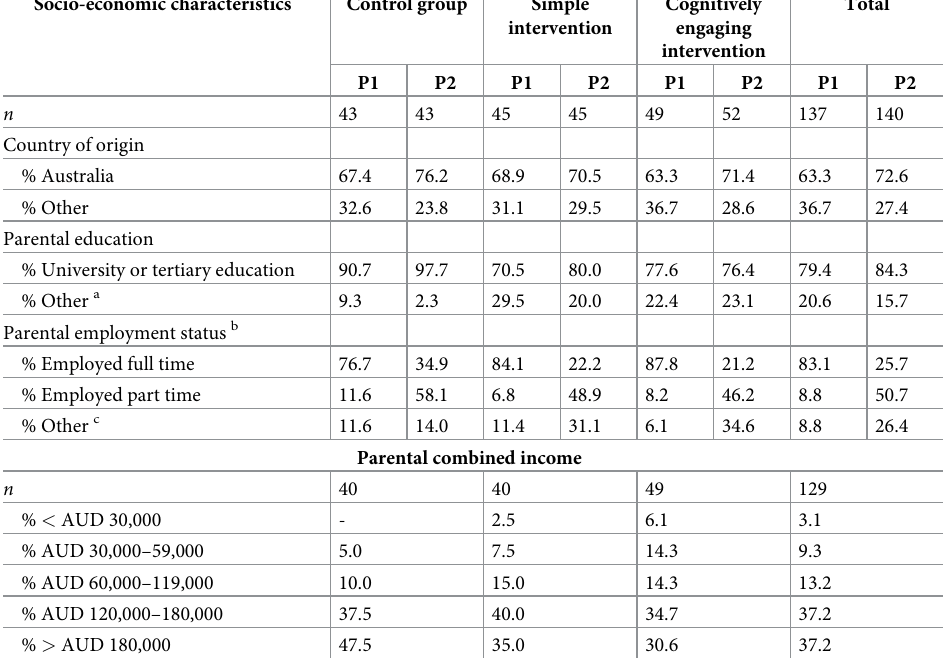
both intervention groups showed lower cerebral activity and improved response time at the cognitive task compared to the control, by the end of trial (Fig 3). The results of the main analysis are displayed in Fig 4. By the end of trial, children in the cognitively engaging intervention showed a significant reduction in the response time at the response inhibition task (approximately –15.40 ms), while maintaining accuracy at the same level (Table 3). Additionally, children in this group showed a significant reduction in attentional lapses (approximately –7.97 ms). Neither response inhibition nor lapses of attention improved significantly by the end of trial for Table 2. Demographic characteristics of